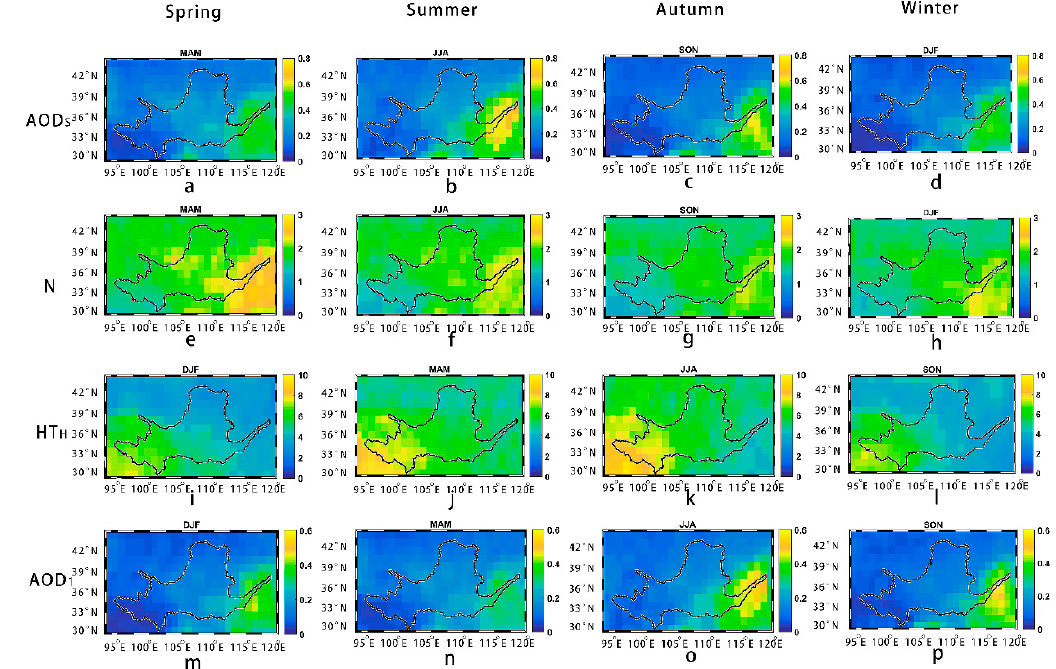
Figure 4. Seasonal distributions of AOD S ( a – d ), N ( e – h ), HT H ( i – l ), and AOD 1 ( m – p ) over the YERB region.